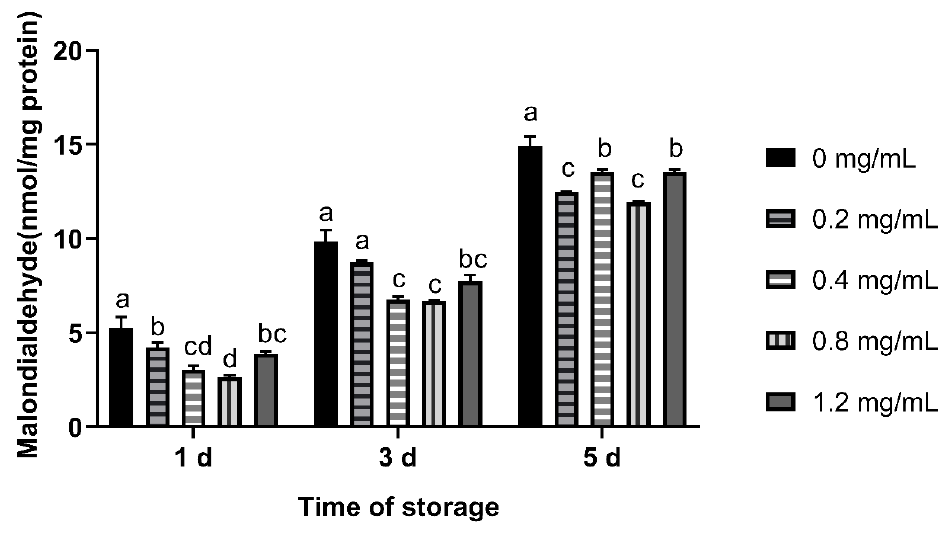
Figure 4. Effects of CGA with different concentrations on MDA content of chilled ram sperm. Note: Different letters above the column indicate significant difference, the same or containing the same letter indicate insignificant difference.